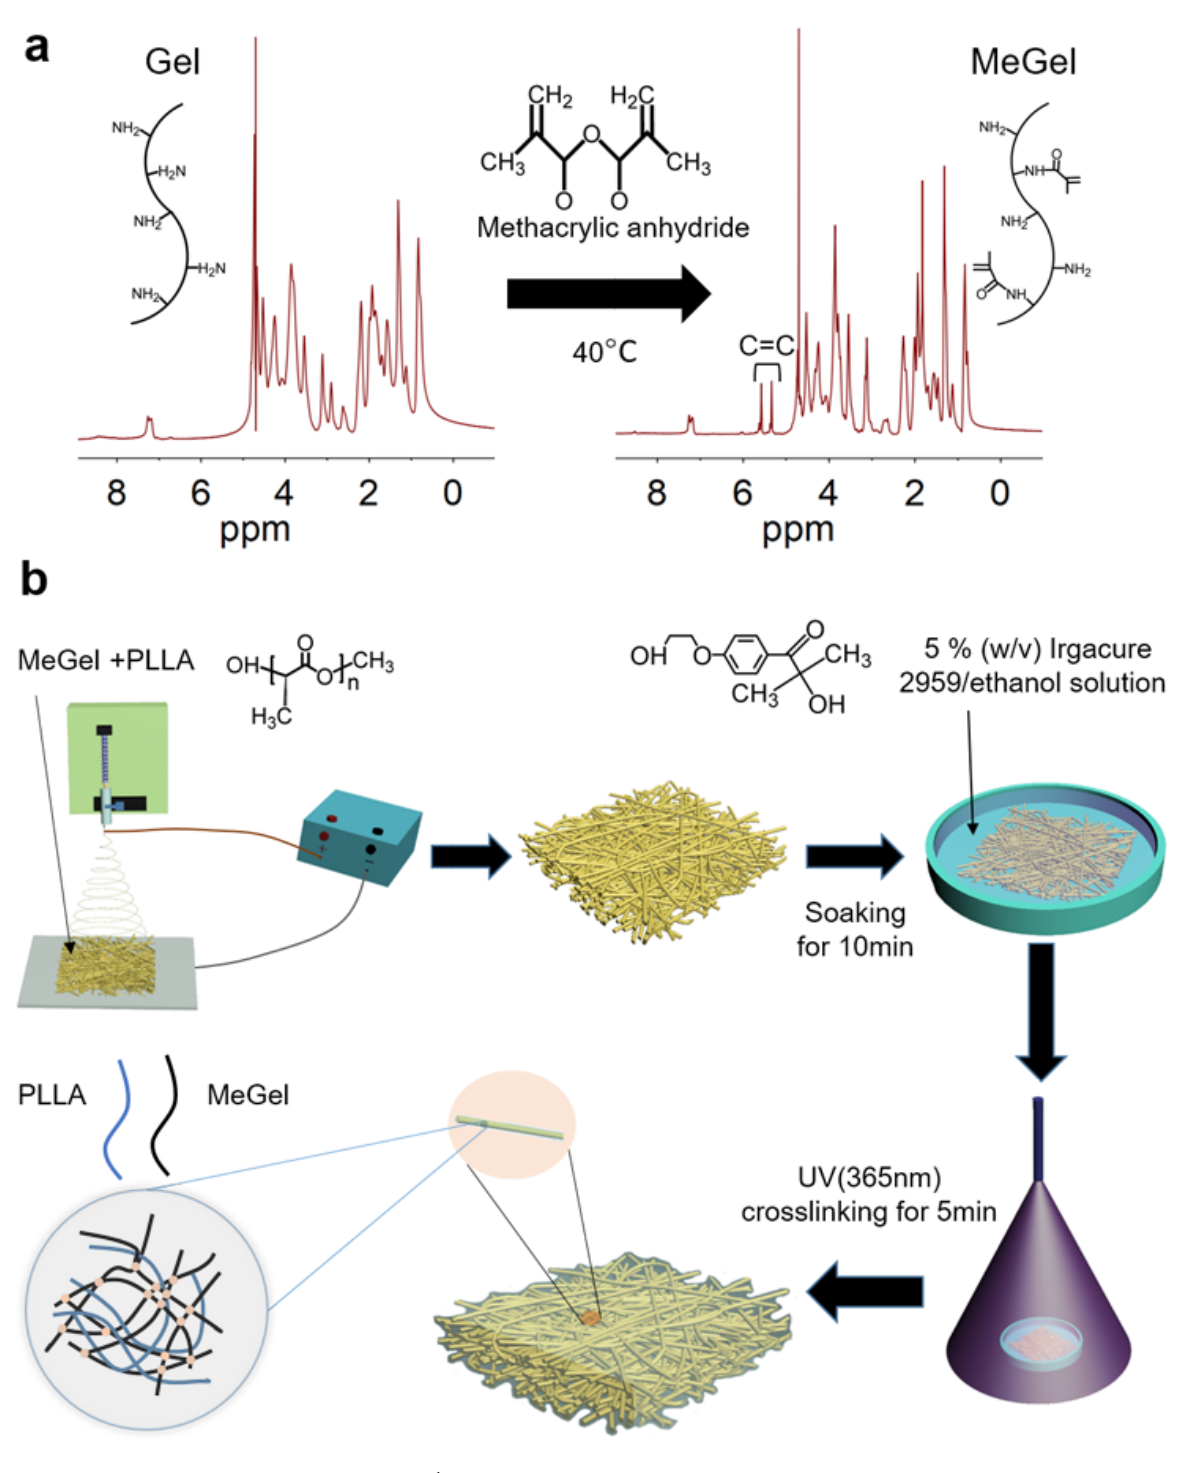
Figure 1. (a) The 1 H ‐ NMR of original Gel and as ‐ prepared MeGel via the methacryloyl substitution of Gel. (b) The schematic of preparation process of MeGel nanofiber mats performed with a combination of electrospinning and UV cross ‐ linking.